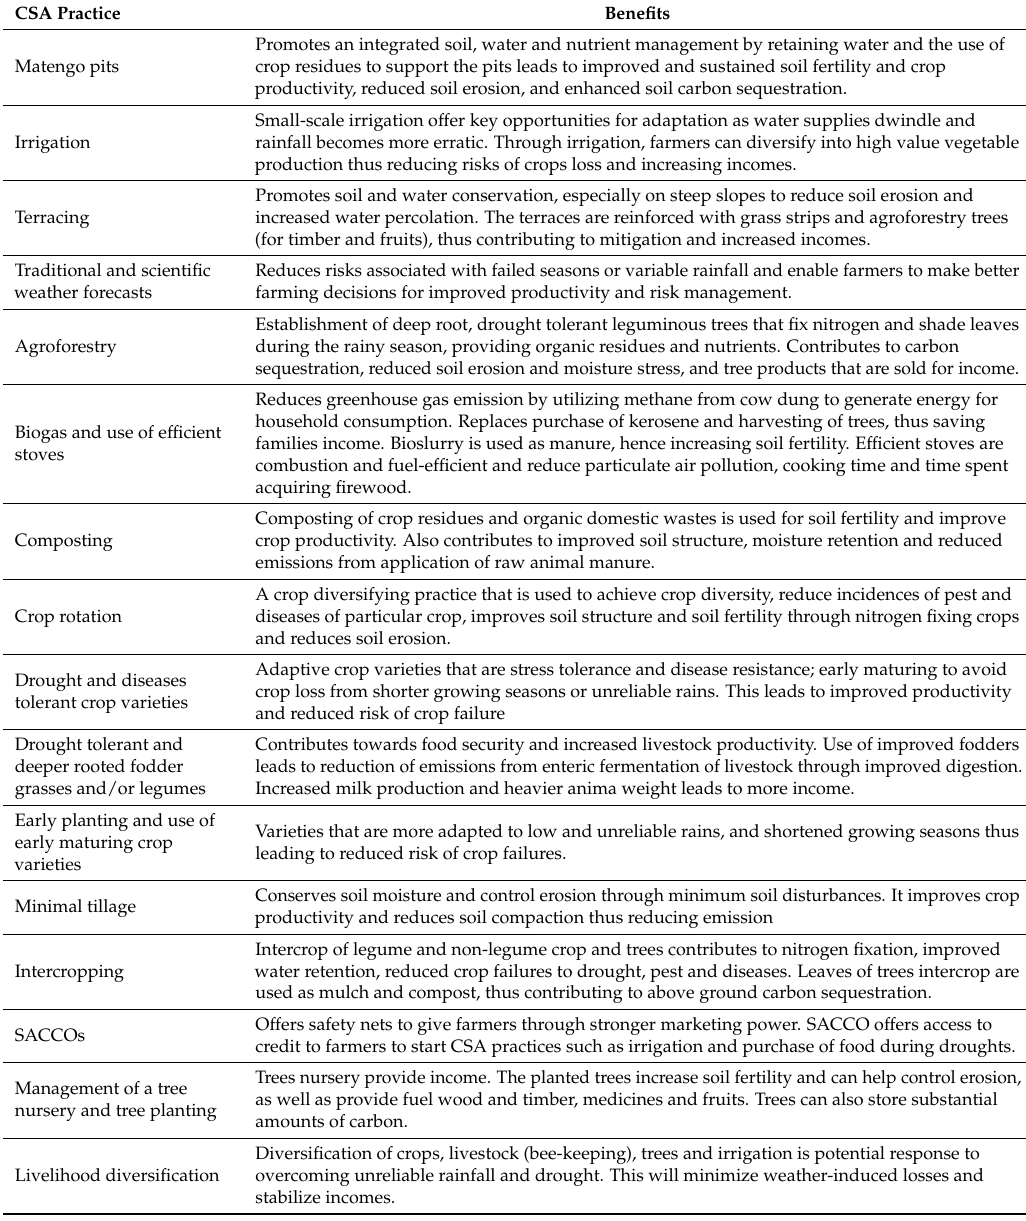
Table 2. Benefits that farmers observe after using various CSA technologies, practices, and institutional innovations (for detailed description see